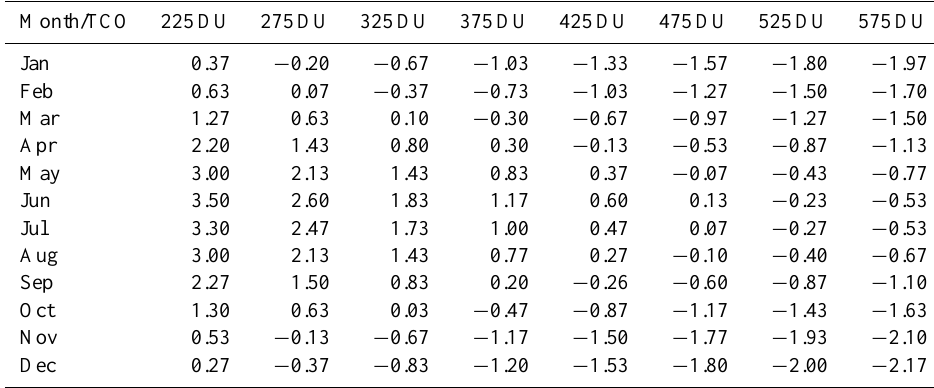
Table 2. Pandora TCO correction in percent as a function of month and ozone amount for 40 ◦ N.